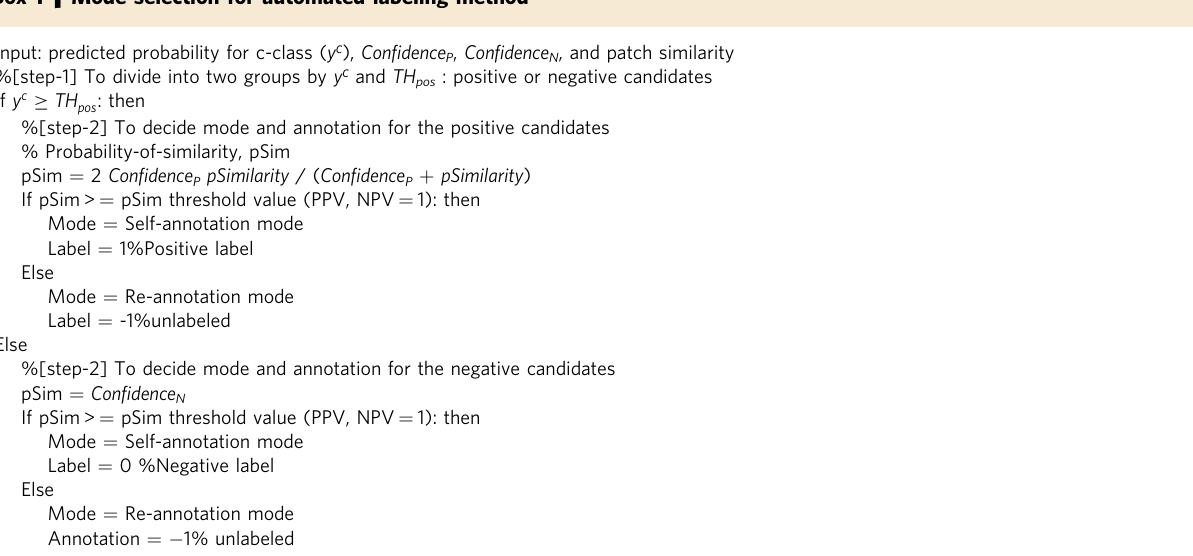
solving the imbalance between positive and negative; α ( ν ) is set to ω if ν is the targeted view, 1 for the others. Design overview for quantitative, explainable, model-derived atlas-based system . Our automated dataset labeling, based on similarity to a validated CXR AI model, requires calculation of two quantitative atlas-based parameters, the “ patch similarity ” and “ con fi dence ” probabilities (values between 0 and 1), as per Fig. 1. For the “ patch similarity ” computation, a patch atlas is generated based on class activation mapping (CAM) 38,39 ; for the “ con fi dence ” computation a distribution atlas is generated based on predicted probabilities (Fig. 1a, b). The harmonic mean between the patch similarity and con fi dence values are then used to calculate a pSim for each clinical output label (Fig. 1c). Predicted probabilities, model ensemble, and distribution atlas creation . To improve the robustness of the entire system, an ensemble of six DenseNet-121 models is composed using unweighted averaging, such that the fi nal probability is determined as an average of probabilities predicted by the six models 40 . Those six models are constructed by independently training with three weights (i.e., ω = 1.1, 1.5, and 2.0 in α ( ν ) ) for PA view, then selecting two models maximized by AUROC and accuracy, respectively. To create the Distribution-atlas, we do inference with the trained AI model on a full training dataset, to obtain two probability dis- tributions of positive and negative samples for the training dataset. These prob- ability distributions are saved as the Distribution-atlas for each clinical output label. Patch atlas creation based on CAM ensemble method . To improve the locali- zation performance of our class activation mapping, we developed an ensemble method as follows: by removing noise components of a single CAM, adding only signi fi cant components, and normalizing it in Eq. (2), the ensemble CAM was able to highlight sharply the overlapping regions among the single CAMs.